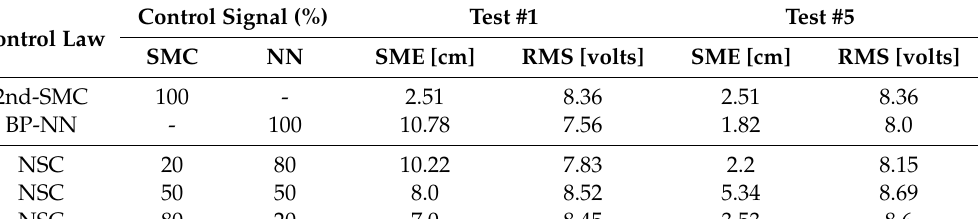
Table 3. Square mean error (SME) and e ff ective value (RMS) comparison for a trajectory of z d = 0.1sin ( t ) + 0.3 m.